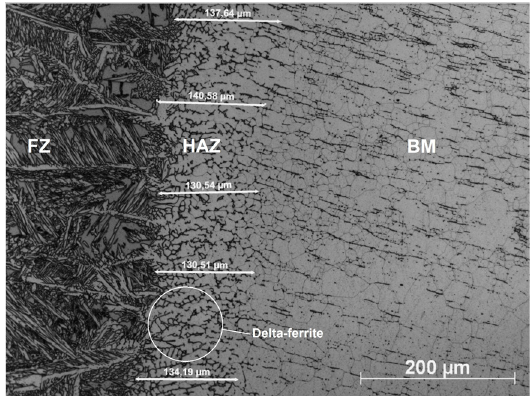
Figure 2. Microstructure of the HAZ of the welded joint with the AWS ER 2209 filler metal and heat input of 8